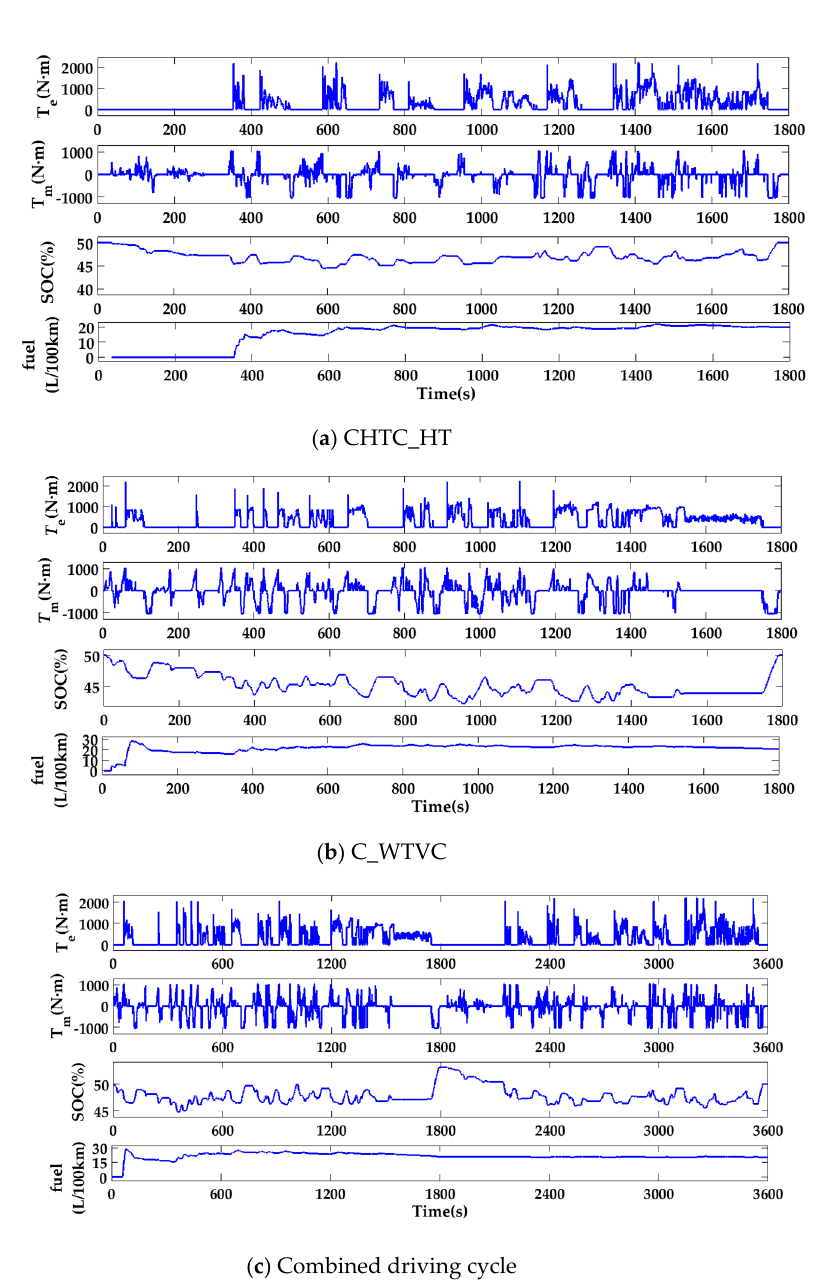
Figure 18. State change of main components under various driving cycle.